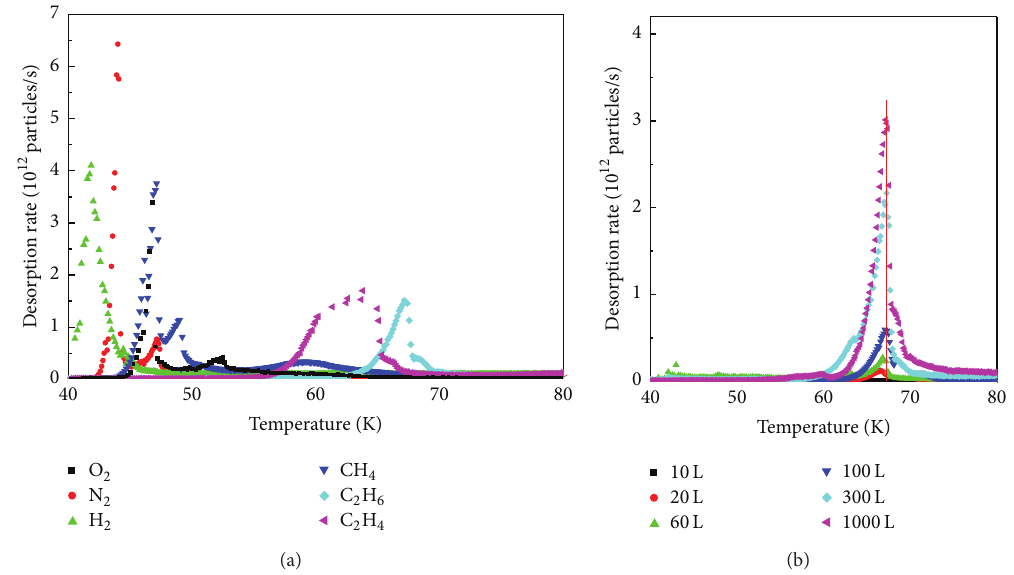
Figure 4: Temperature programmed desorption traces of molecular gases adsorbed on Ag/MWCNT composites at a dose of 1000 L (a). TPD traces of adsorbed C 2 H 6 at different doses as example for all gases (b).